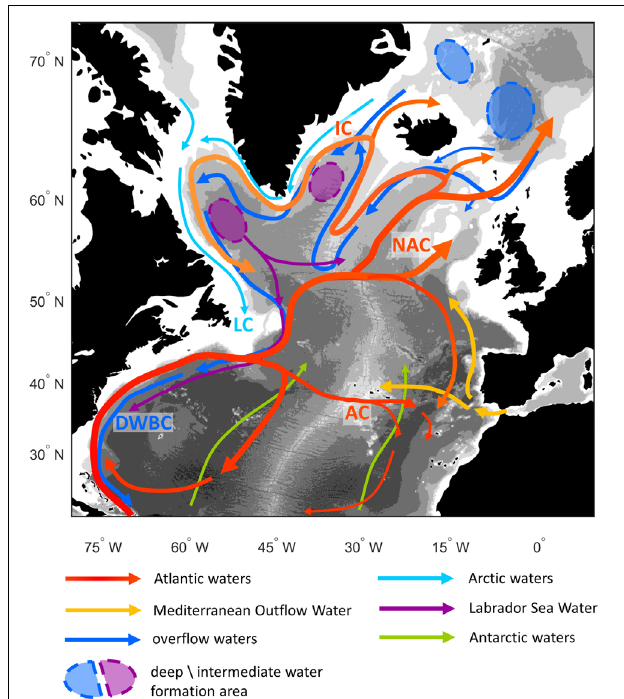
FIGURE 1 | Schematic of the main circulation in the North Atlantic Ocean color coded by water mass type. Main currents are labeled as: the North Atlantic Current (NAC), Azores Current (AC), Irminger Current (IC), Labrador Current (LC), and Deep Western Boundary Current